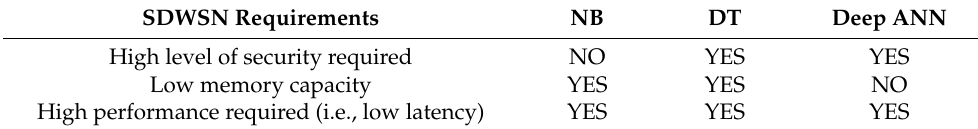
Table 13. Choice of Anomaly Detectors for SDWSNs (binary classification).